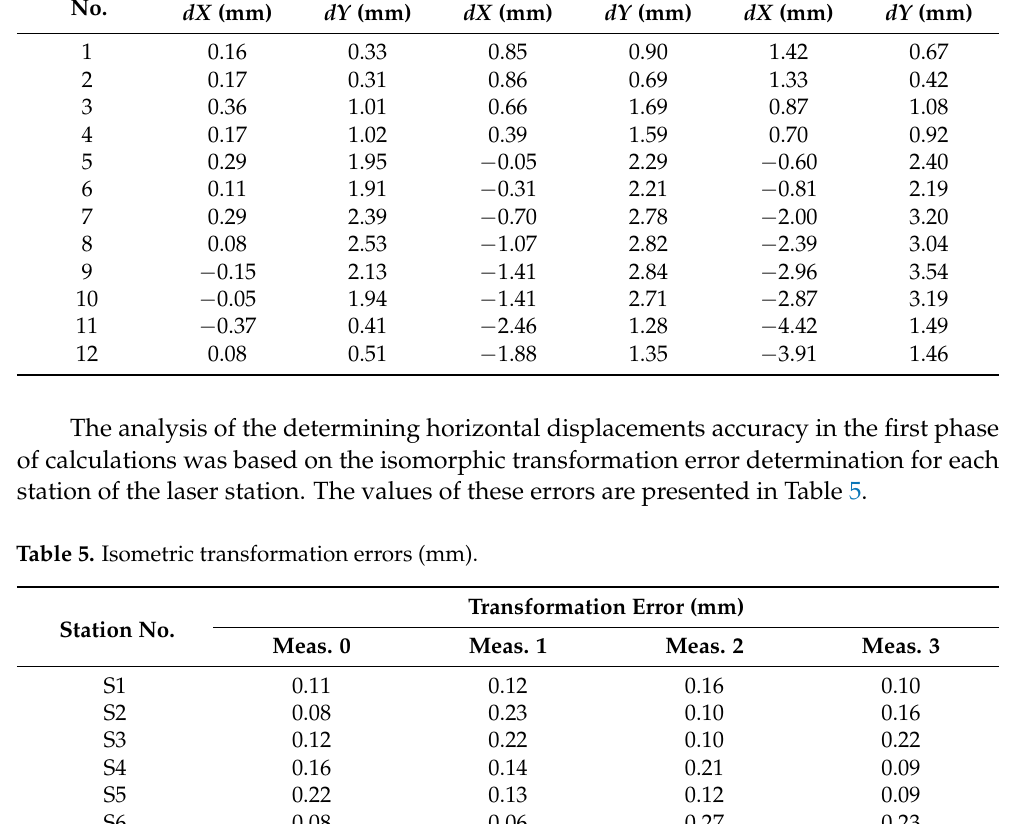
Table 4. Determined horizontal displacements values. Point